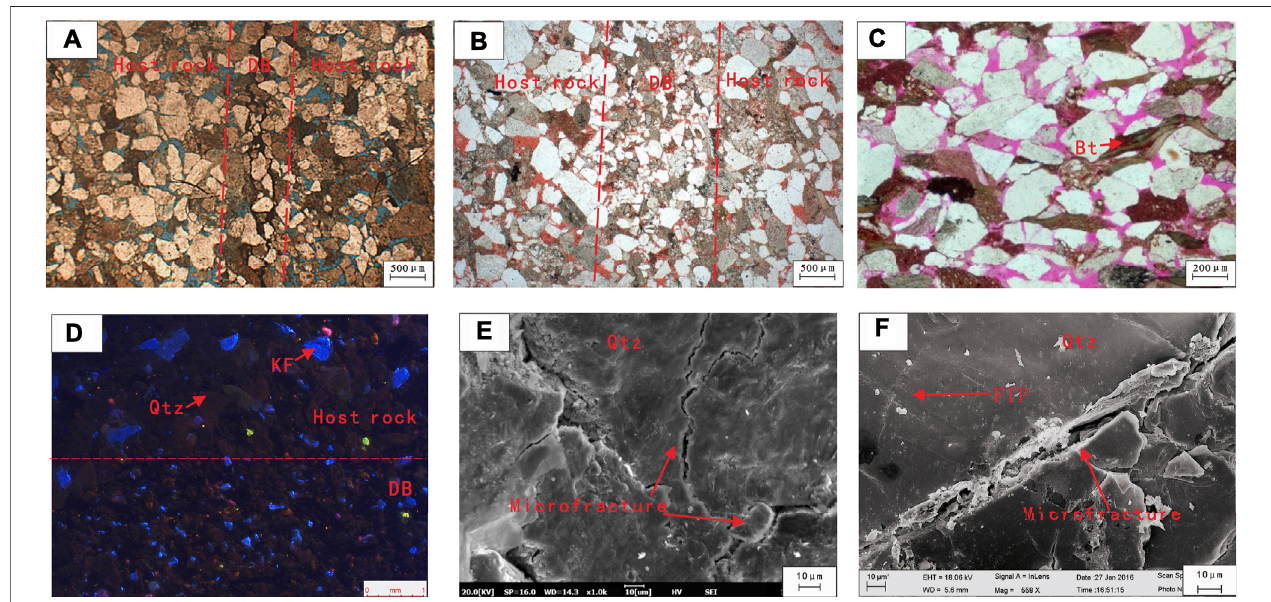
FIGURE 5 | (A) The microscopic characteristics of the disaggregation band, LN2-3-1, 4,871 m, porosity is shown in blue, plane-polarized light (PPL). (B) The microscopic characteristics of the CSB, feldspar, and quartz grains in the CSB are fragmented as crush micro-breccia and block the primary pore throats, LN31, 4,745 m, PPL. (C) Deformed biotite squeezed into the primary pore, LN30, 4,714 m, PPL. (D) Comparison of the composition and grain size of the host rock and deformationband;feldspar(blueluminescent)hasahigherleveloffragmentationcomparedtoquartz(non-luminescent),LN44,4,971 m,CL. (E) “ Hertzian ” contact points, which isasingular contact between twograins, formed preferred orientation offracturesthroughgrains, SEM. (F) Microfractures and quartz- fi lled microfractures (FIP) formed in the quartz grains, LN44, 4,971 m, SEM. Qtz, quartz, KF, K-feldspar, Bt, biotite, DB, deformation band, red dotted lines is the band boundary.